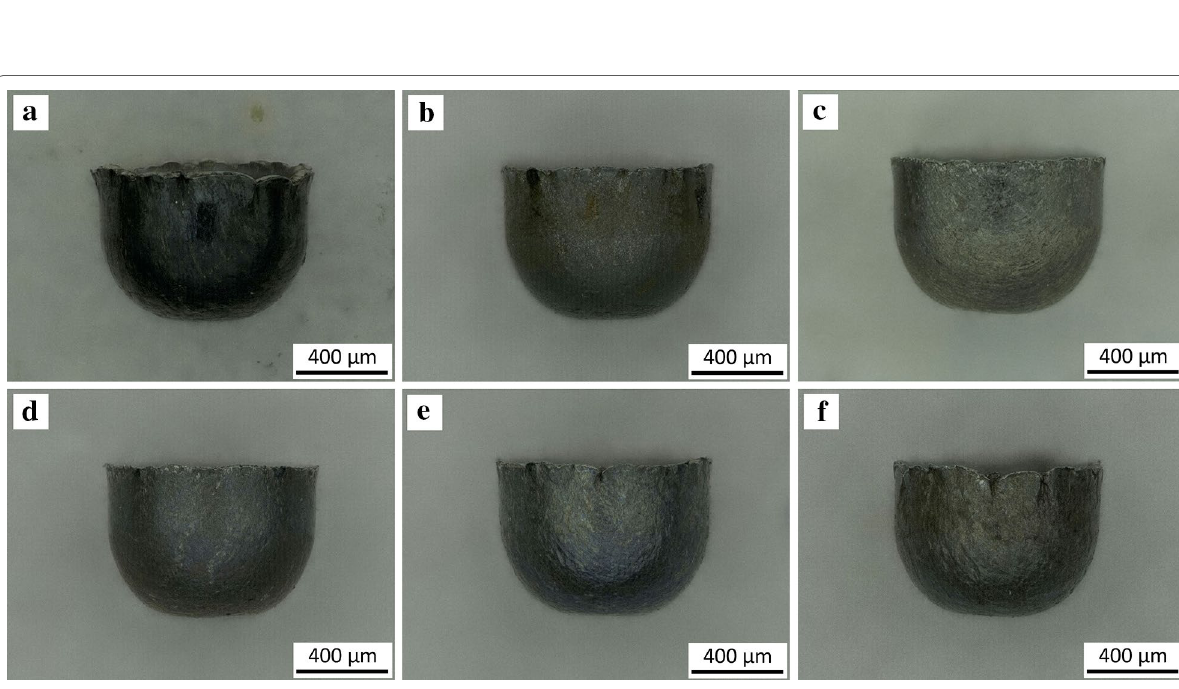
Figure 10 Side views of the drawn cups with annealed specimens: a A700, b A850, c A900, d A950, e A1000, f